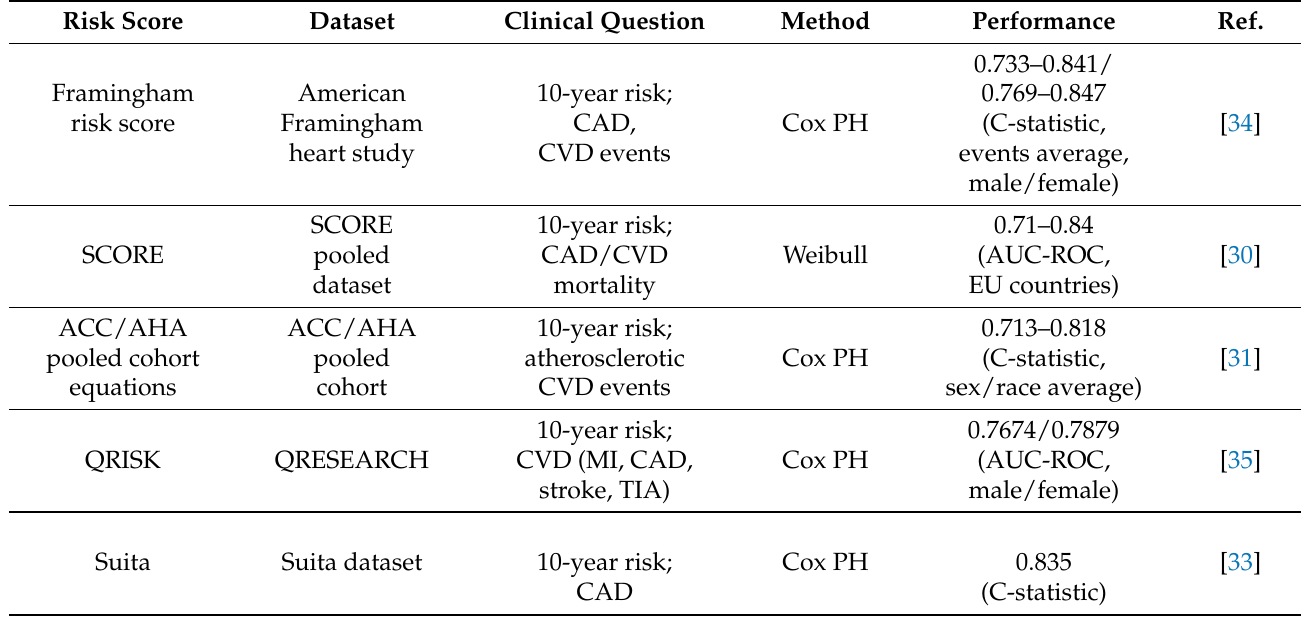
Table 2. Table of traditional risk scores based on clinical datasets. MI—myocardial infarction; TIA—transient ischaemic attack; CAD—coronary artery disease; CVD—cardiovascular disease; PH—proportional hazards.